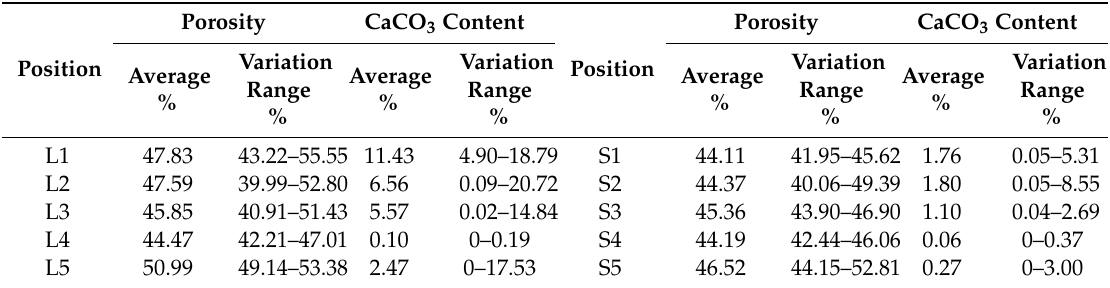
Figure 3. Variations of CaCO 3 content, porosity, and magnetic susceptibility of di ff erent loess / paleosol layers in the Chinese Loess Plateau southern. Notes: Li and Si respectively on behalf of loess and paleosol. The letter i is the number of the layer. S4 (cid:48) layer is located at the top of the L5 stratum, and it is considered to be contained in the L5 stratum. Table 2. Porosity and CaCO 3 content of loess / paleosol layers in the Chinese Loess Plateau